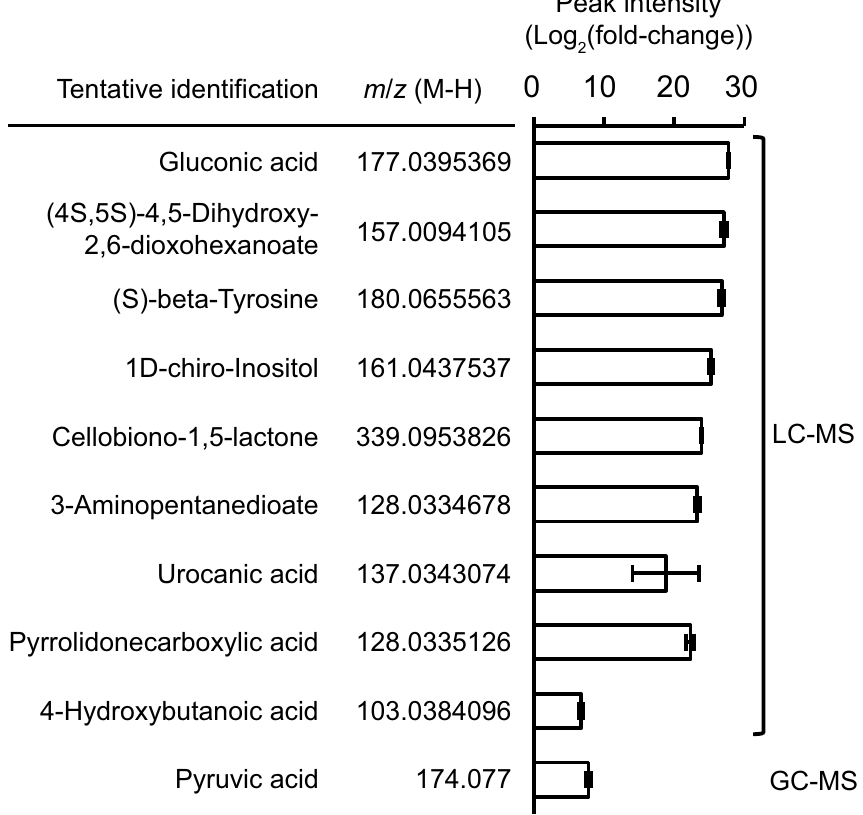
Figure 3. Ten most significantly abundant metabolites detected from the extract of cell-free fermented broth of Lactip. plantarum strain L75a. To distinguish compounds affiliated to the medium from the metabolites excreted by Lactip. plantarum , a set of MRS broth cultures without inoculation of the isolate was included as ‘control’. The pyruvic acid was detected by GC-MS and the other 9 metabolites by LC-MS. The fold-change was calculated by comparing the peak intensity of each metabolite in the cell-free fermented broth of Lactip. plantarum to the mean peak intensity of the corresponding compound in the control. The significance of the abundance of these 10 metabolites was determined by the fold-change of peak intensity (fold-change > 100). Error bars represent S.E.M. of LC-MS ( N = 5) and GC-MS ( N = 6)